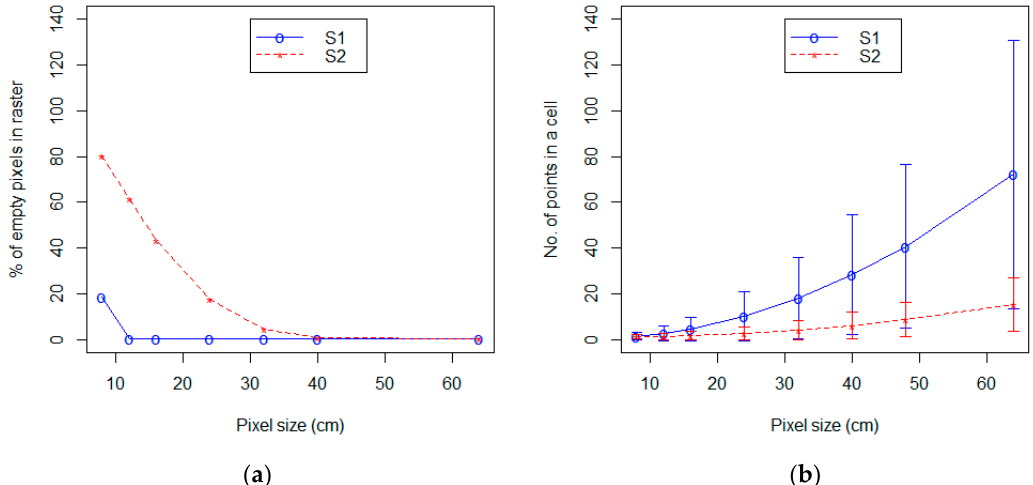
Figure 3. Graph showing ( a ) the percentage of empty pixels in the raster and ( b ) the number of points in a pixel as the pixel size changes.